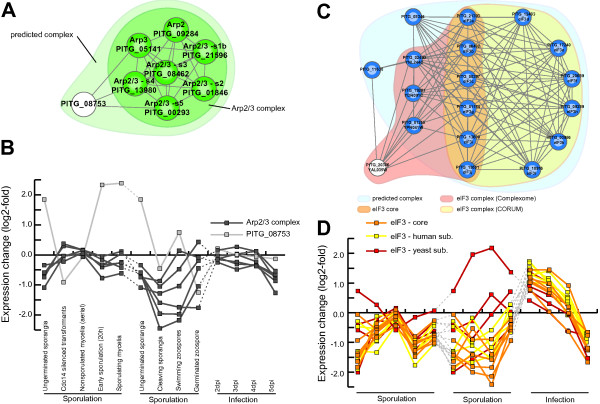
Predicted Arp2/3 and eIF3 complexes in P. infestans. (A) Automatically predicted Arp2/3 complexes (ClusterONE prediction in light green) include the seven conserved subunits of the eukaryotic Arp2/3 complex (Arp2, Arp3 and the five associated subunits; highlighted in dark green). (B) Gene expression of the predicted Arp2/3 complex (note: there is no gene expression data for Arp2/3 subunit 5 [BROAD:PITG_00293]). The log2-fold change in expression at different time points/developmental stages (averaged replicates) of three different gene expression experiments compared to the gene expression in mycelium/hyphae growth of the respective experiment is displayed in the graph. (C) Automatically predicted eIF3 complex (ClusterONE prediction in light blue), the annotated eIF3 complexes based on CORUM (yellow) and Complexome (red) database as well as the conserved eIF3 core (six subunits; orange). (D) Gene expression of the eIF3 core complex (orange) and the additional subunits predicted by either CORUM (yellow) or Complexome (red). The log2-fold change in expression at different time points (averaged replicates; description as in (C)) of three different gene expression experiments compared to the gene expression in mycelium/hyphae growth of the respective experiment is displayed in the graph.